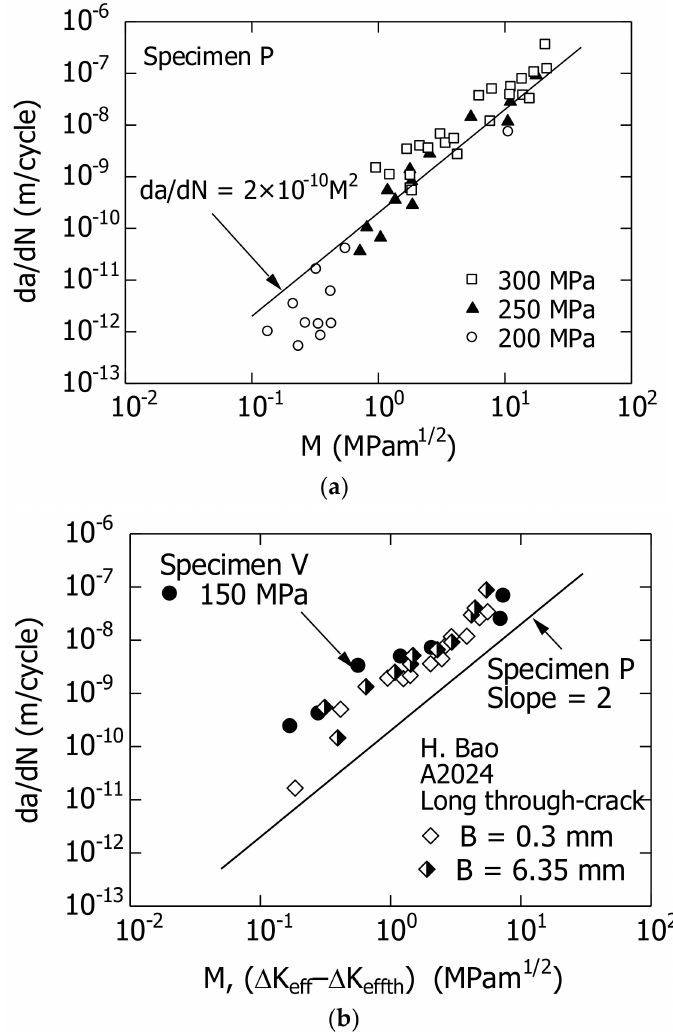
Figure 11. Relationship between da/dN and M of extruded A2024-T3 aluminum alloy. ( a ) Specimen P; ( b ) Specimen